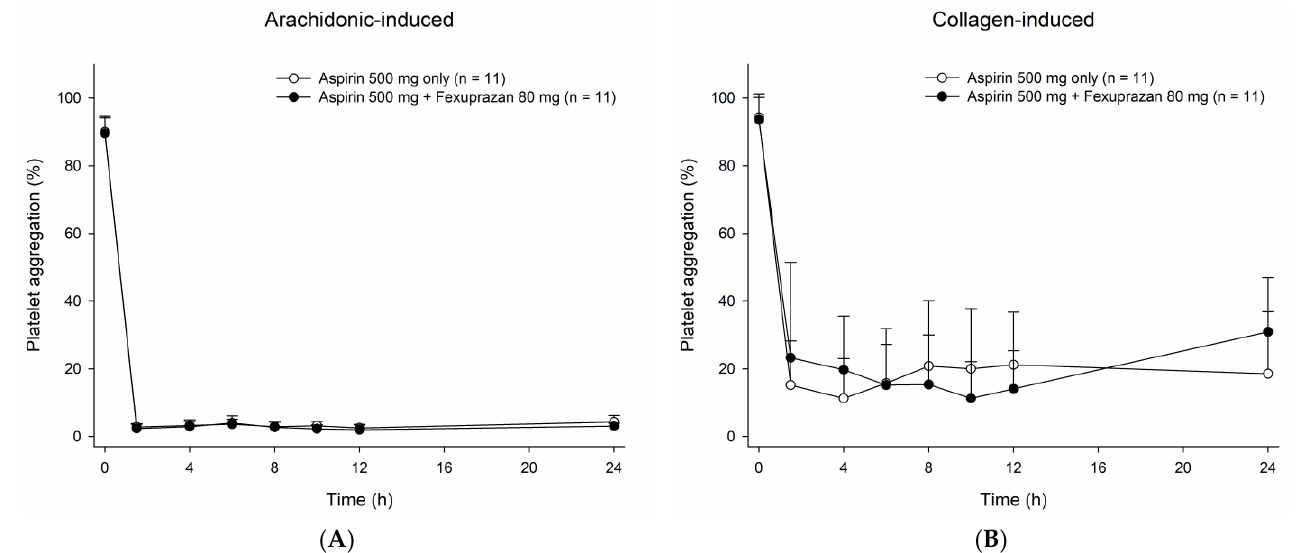
Figure 1. Platelet aggregation-time profiles obtained after a single oral administration of aspirin 500 mg with and without the coadministration of fexuprazan 80 mg in ( A ) arachidonic acid-induced assay and in ( B ) collagen-induced assay. The error bars represent the standard deviations.